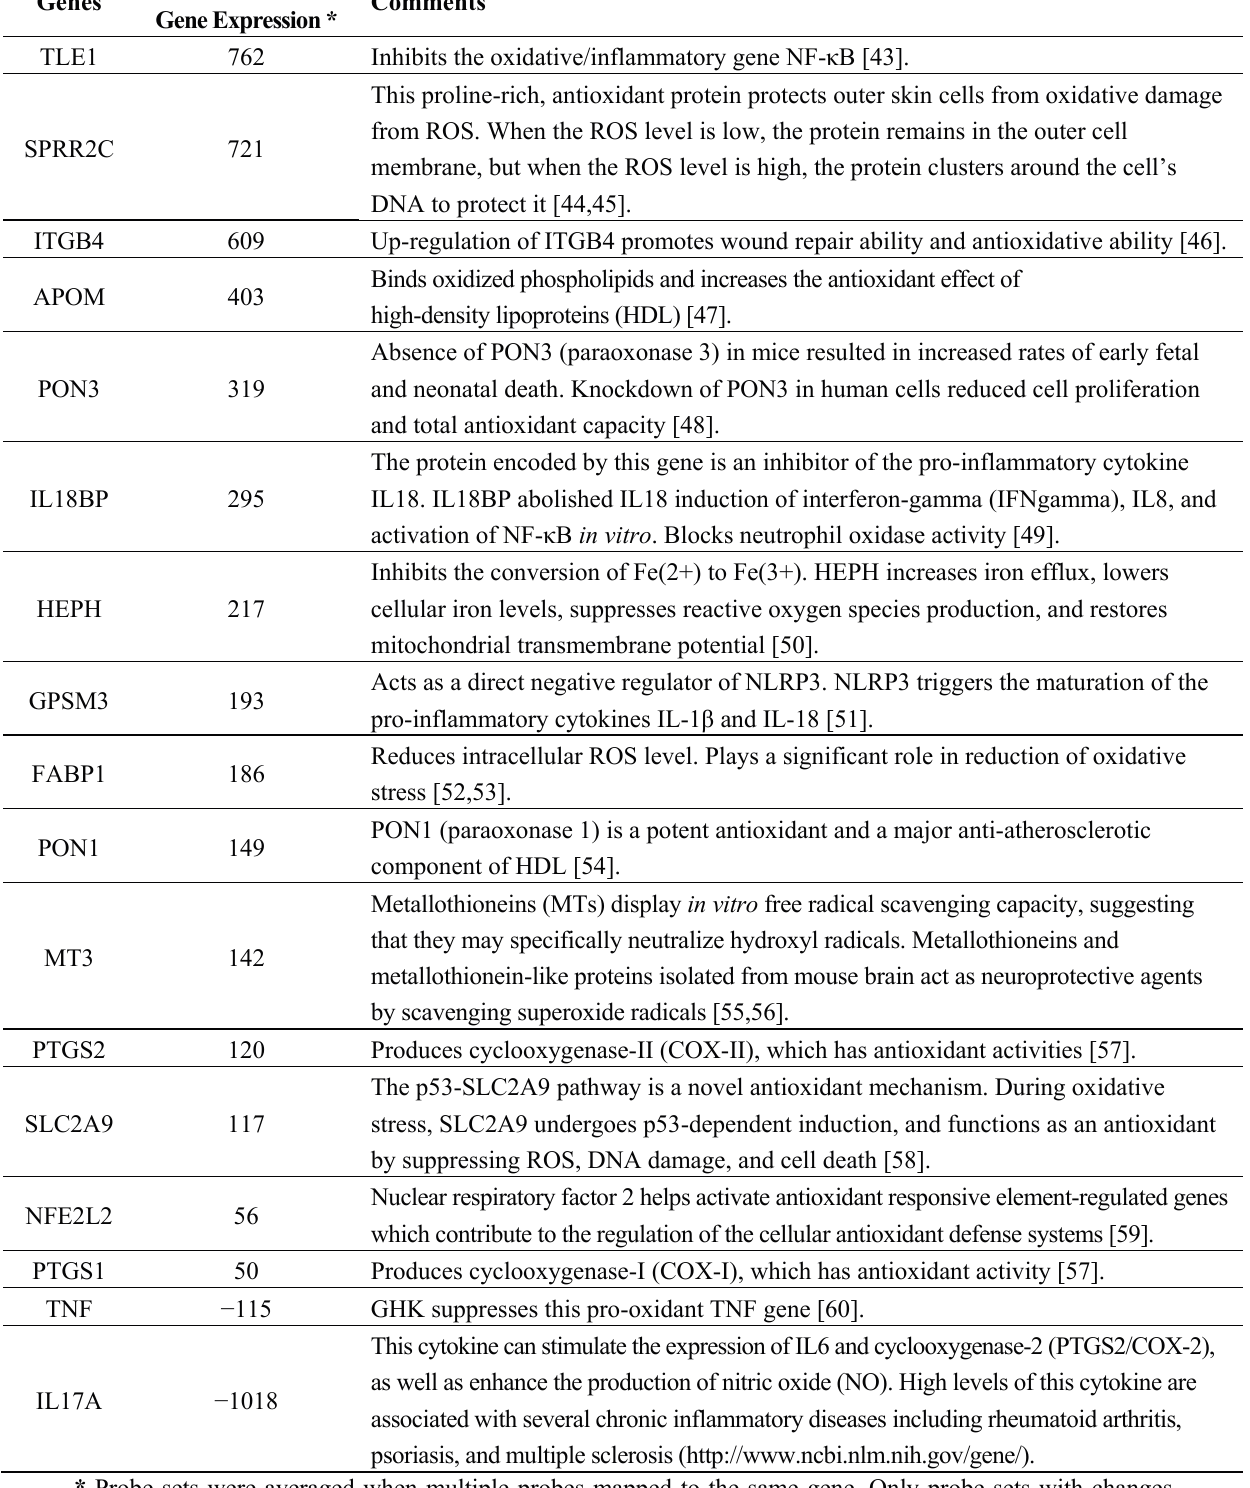
Table 3. Gene expression related to antioxidant